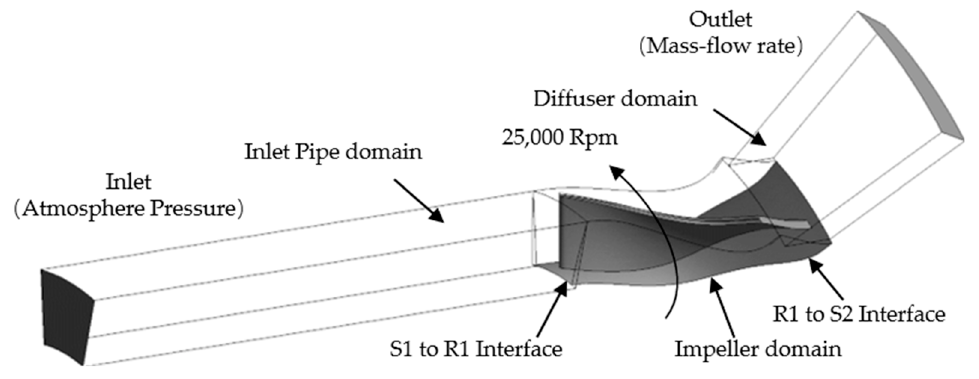
Figure 3. Computational domain.